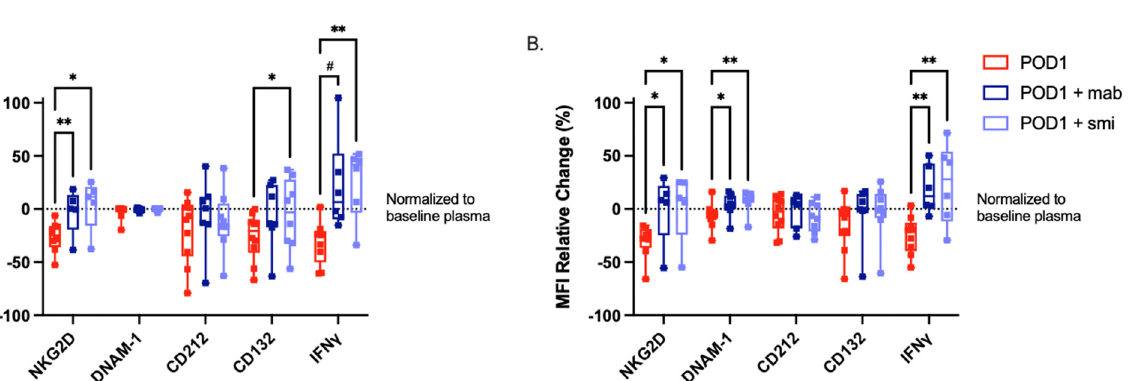
Figure 3. Postoperative NK cells show increased TGF- β and POD1 plasma induces NK cell dysfunction in vitro. ( A ) Platelet-free plasma was isolated by centrifugation from whole blood from 25 baseline and POD1 patients undergoing cancer surgery. TGF- β was quantified by ELSA. Median ± IQR is shown ( p = ns). ( B ) Single-cell RNA sequencing in six patients with colorectal cancer underwent TGF- β activity analysis. Median ± IQR is shown. Flow cytometry staining showing expression, ( C ) %, and ( D ) MFI of NK activating receptors, NKG2D, DNAM-1, CD212, CD132, and intracellular IFN γ in NK cells isolated from health donors incubated in the absence (green) or presence (purple) of recombinant TGF- β (10 ng/mL). Healthy donor isolated NK cells were also incubated with baseline (blue) or POD1 (red) plasma and expression, ( E ) %, and ( F ) MFI of the same targets as ( C , D ) were determined. * p ≤ 0.05, ** p ≤ 0.005, *** p ≤ 0.0005.